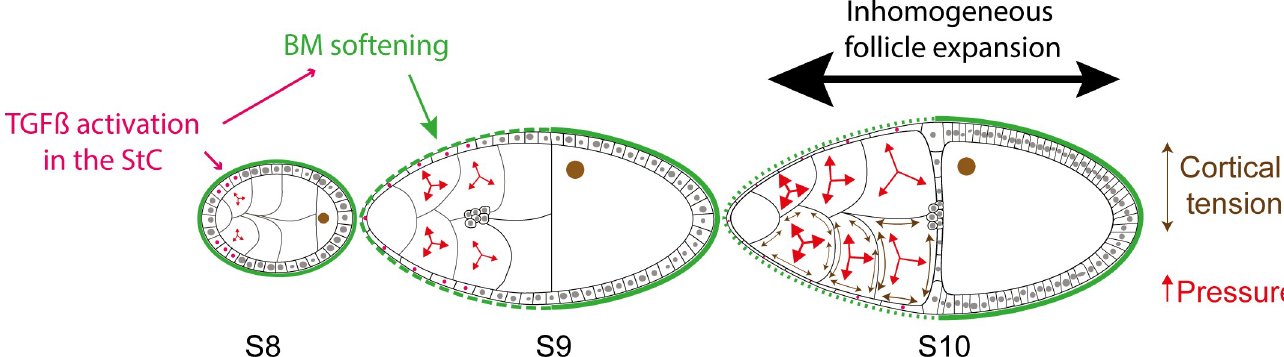
Fig 7. Model of the role of the NC cytoplasmic pressure on StC flattening and follicle elongation. From S8 to S10, a gradient of NC pressure (small to large red arrows) is established. When NC pressure reaches a certain level, it induces TGF β signaling in the surrounding StC (pink), allowing their flattening. The cortical tension (double-sided brown arrow) appears to be inhomogeneous at LS9 and S10 (for simplification, it has been drawn at S10 in only half of the NC). In parallel, TGF β controls BM remodeling and softening (dotted to plain green line) [31]. This favors anterior follicle expansion (large black arrow) versus posterior expansion (small black arrow), allowing the growth of the NC. This growth allows the maintenance of the pressure, which continues to increase during S9 and S10, under a certain threshold, preventing NC membrane breakage. BM, basement membrane; LS9, late S9; NC, nurse cell; S, stage; StC, stretched cell.